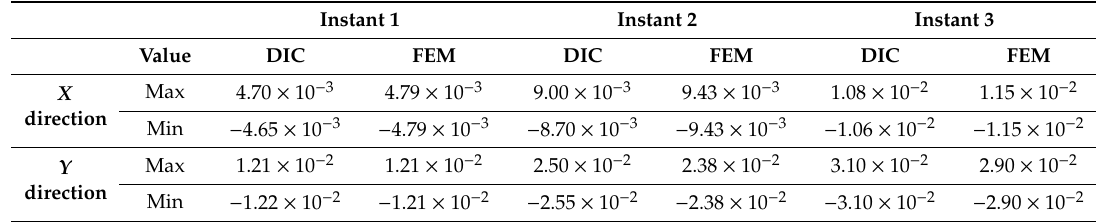
Table 5. Maximum and minimum displacement values for geometry